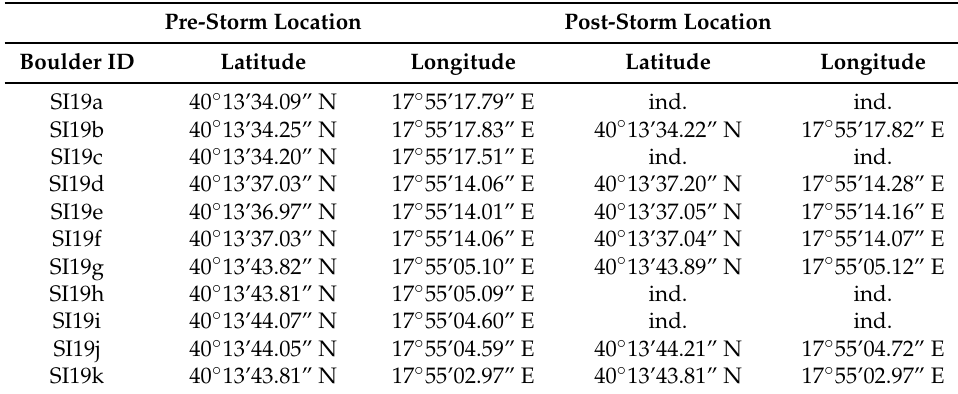
Table 2. Pre- and post-geographical coordinates of the displaced boulders; ind., indeterminable. Pre-Storm Location Post-Storm Location Boulder ID Latitude Longitude